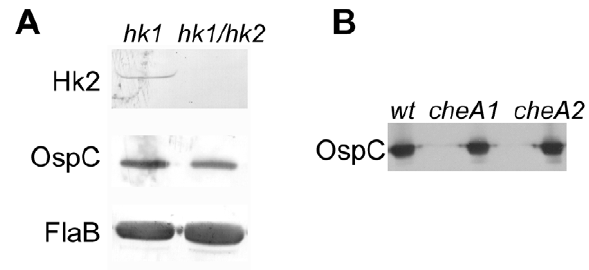
Figure 4. The hk1hk2 double mutant and the cheA1 or cheA2 mutant have normal level of Rrp2 activation. Various strains of spirochetes (labeled on the top) were grown at 35 u C, harvested in the late logarithmic phase (5 6 10 7 spirochetes/ml), and subjected to immunoblot analysis using monoclonal antibodies specific against Hk2, OspC or FlaB as indicated.